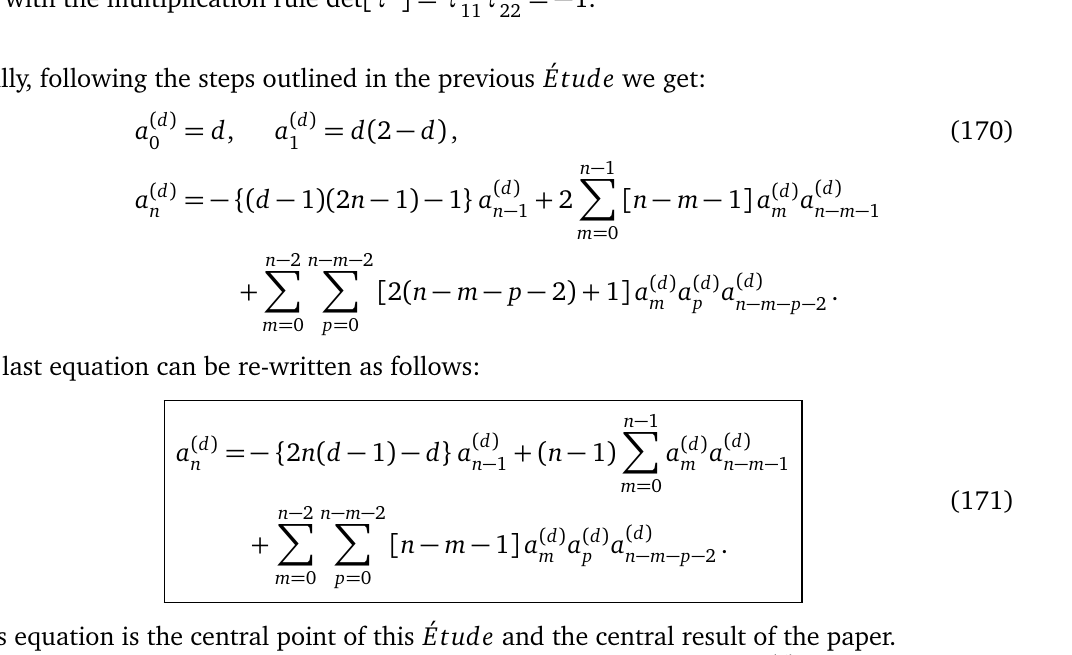
Figure 14: We illustrate why for d > 2 the coefficient a take an example d = 3. The Feynman diagrams contain wavy line denoting z − z noise correlator and dashed line denoting + − = x x + y y noise correlator. It is straightforward to show that three 3rd order irreducible diagrams come with factors − 2 another − 2 and + 1 which gives finally overall factor − 3. Sign − is associated with the multiplication rule det [ τ z ] = τ z